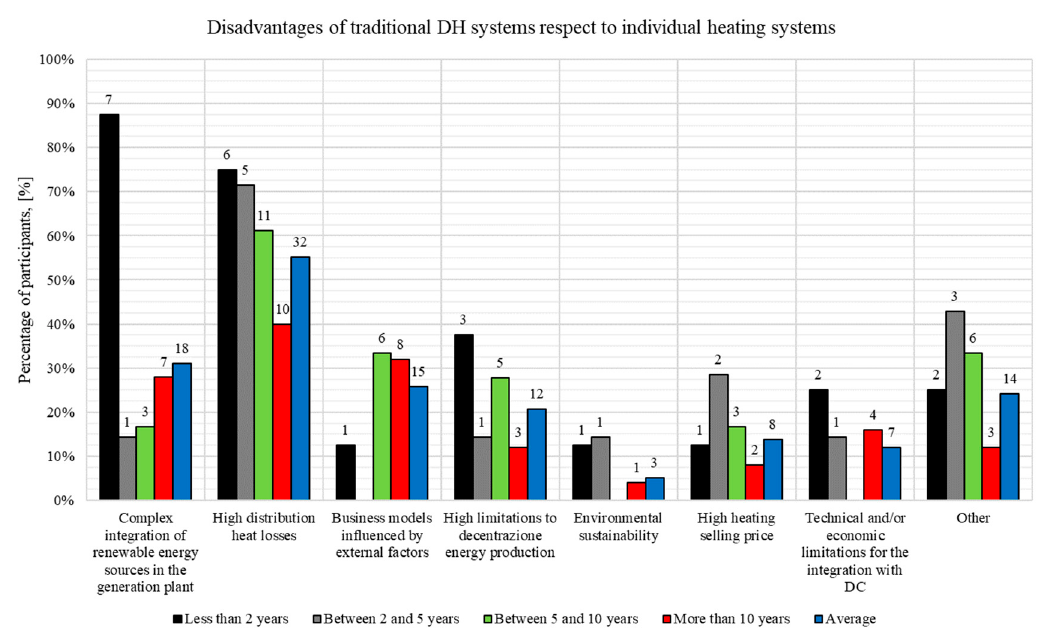
Figure 20. Disadvantages of traditional DH systems with respect to individual heating systems as a function of the experience.